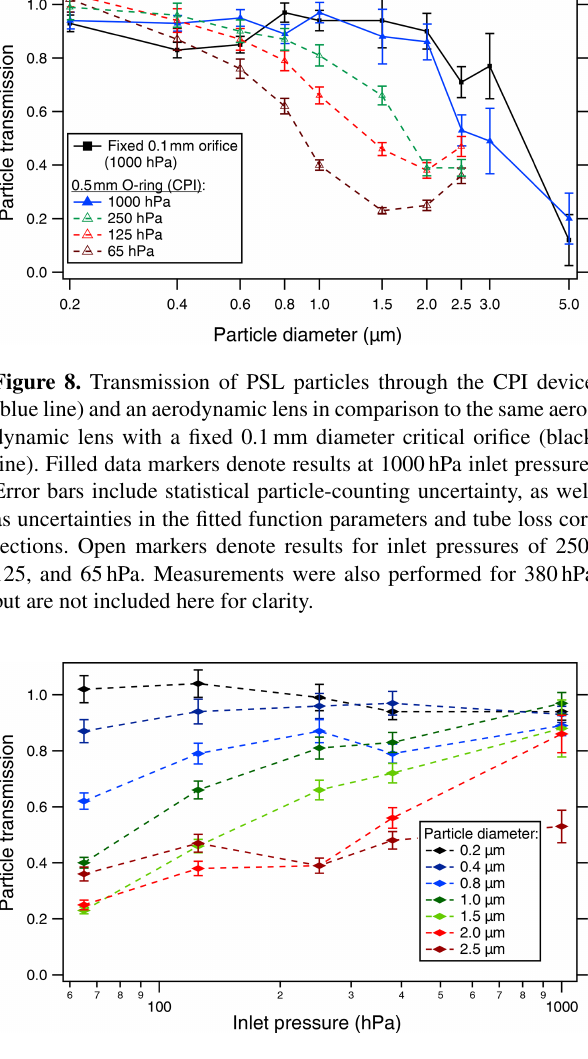
Figure 9. Transmission of PSL particles through the CPI device and an aerodynamic lens as a function of inlet pressure. Different PSL particle sizes from 0.2 to 2.5µm were used in this experiment. Error bars include statistical particle-counting uncertainty and the uncertainty in the maximum detection-to-transmission